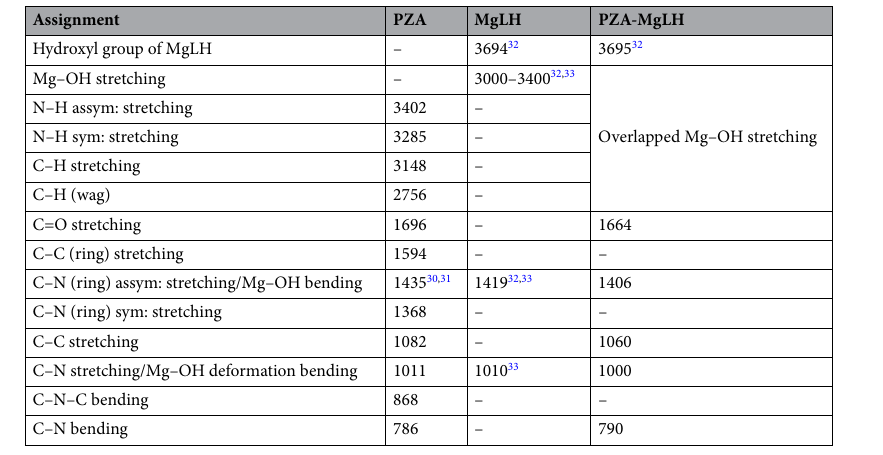
Table 1. The FTIR absorption bands of PZA, MgLH and PZA-MgLH.